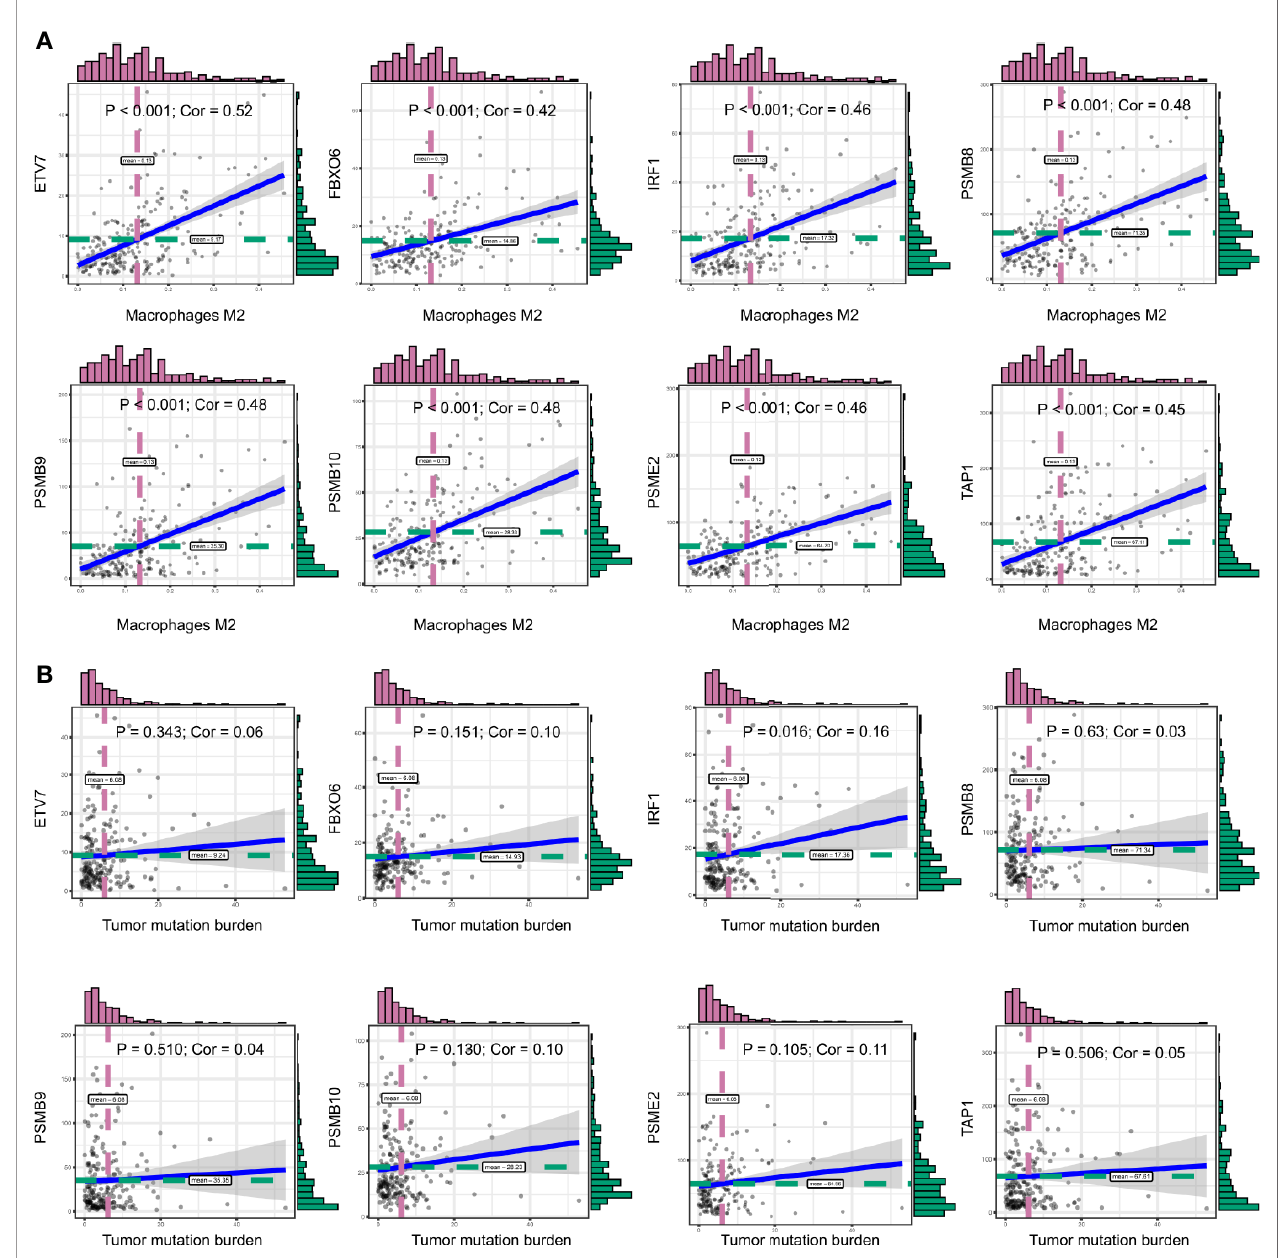
FIGURE 5 | (A) The correlation between co-expression genes and CD8+ T cells proportion. (B) The correlation between co-expression genes and tumor mutation burden